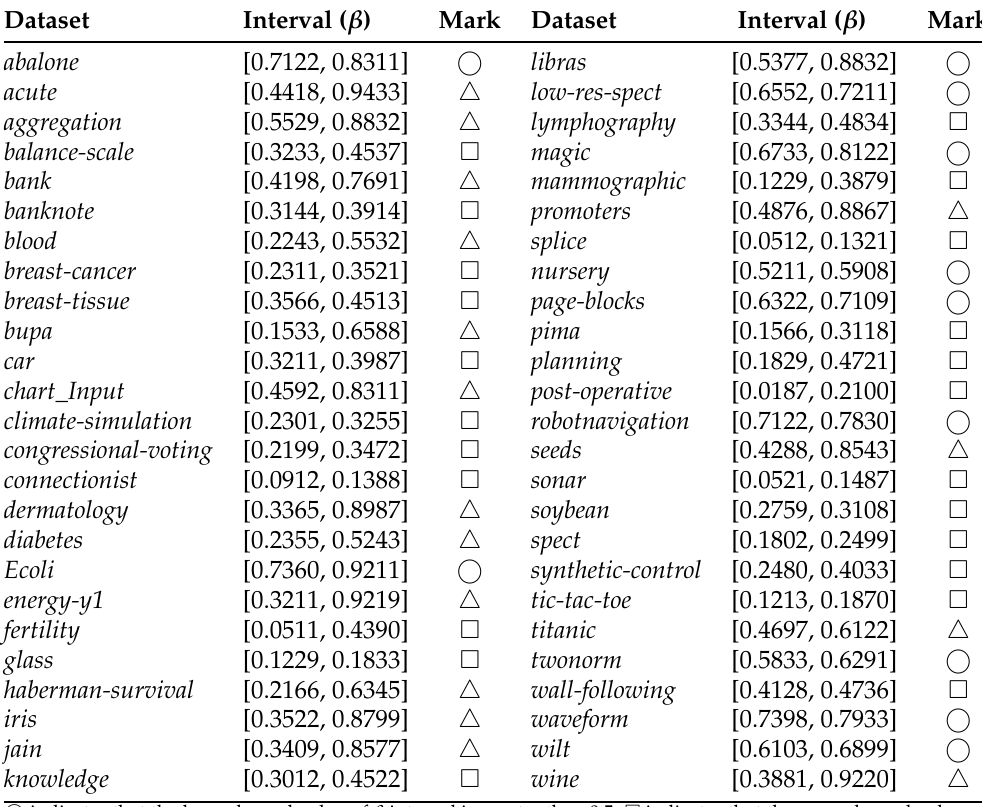
Table 14. The interval of regulatory factor β on 50 UCI